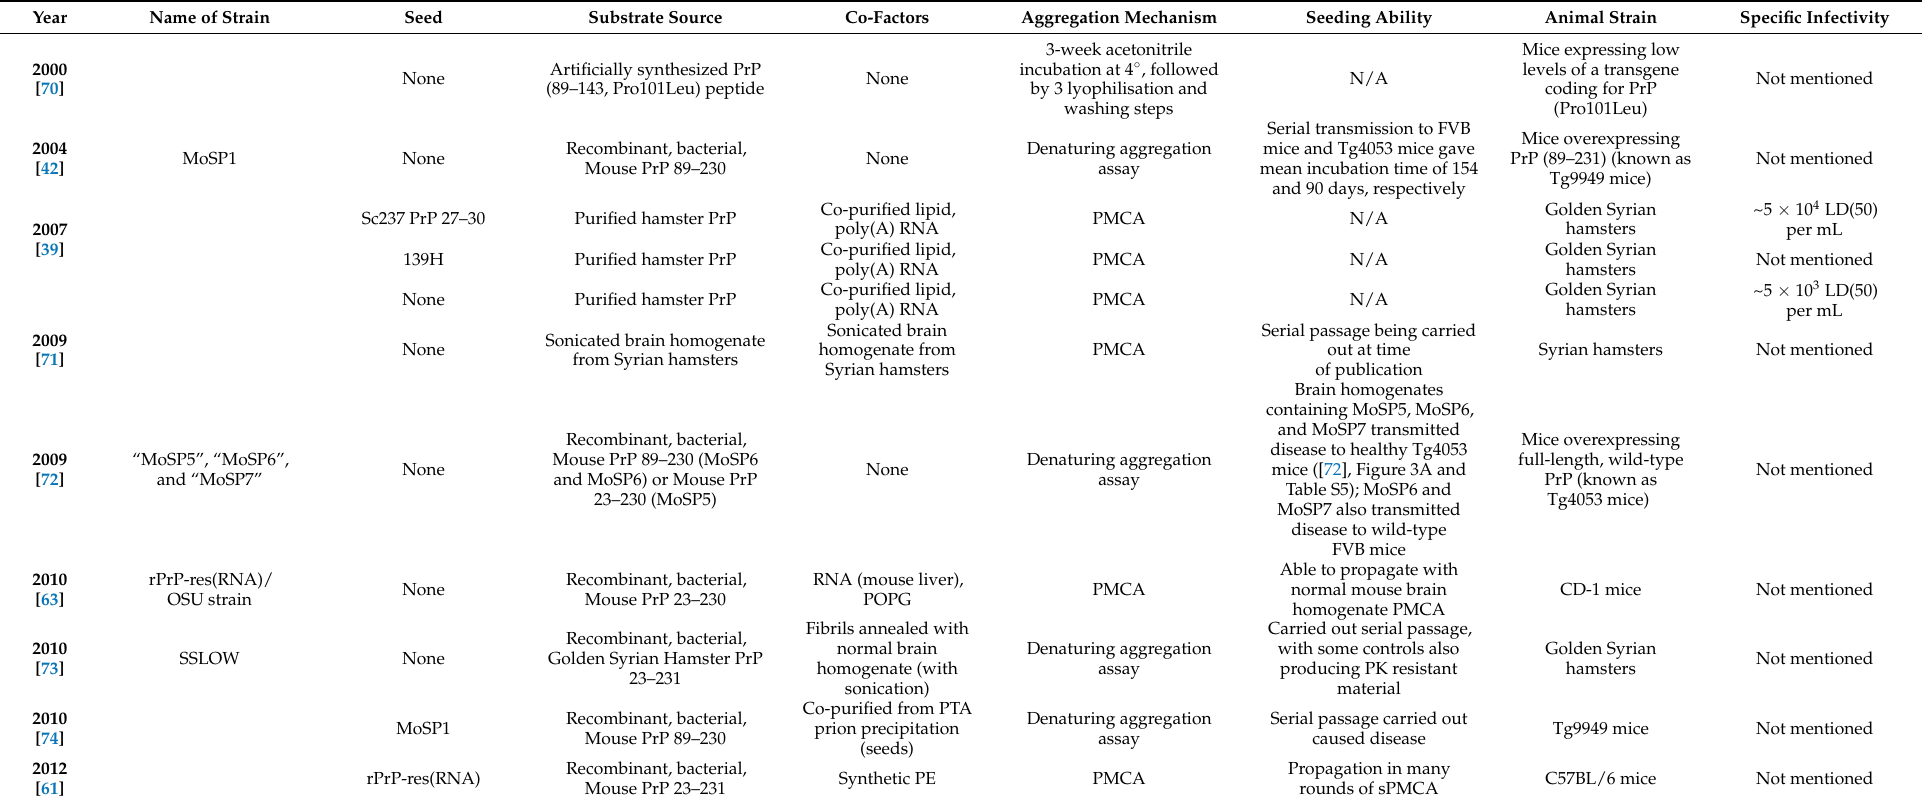
Table 1. Comparison of the main reports of de novo synthetic prion generation over the last twenty years. Further details, including buffer conditions, specific infectivity and incubation period (where available in the papers) can be found in the supporting information. * This high specific infectivity has to date not been replicated using the same conditions